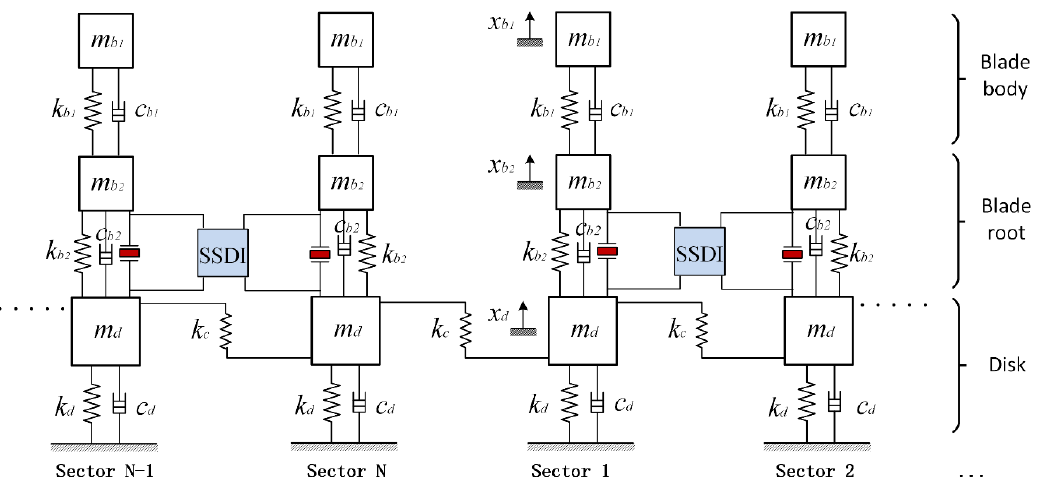
Figure 17. Lumped parameter model of blisk with dual-connected SSDI shunt.